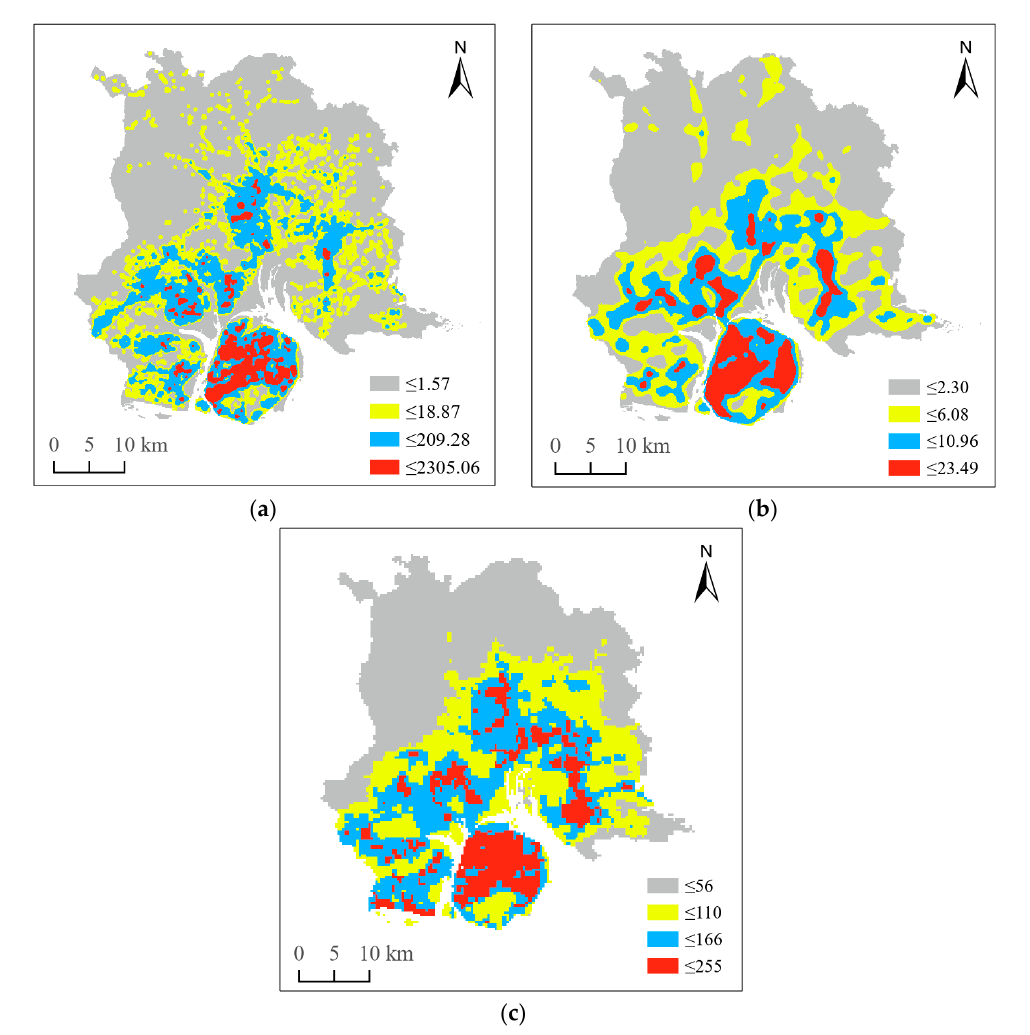
Figure 4. Intensity maps of ( a ) POI, ( b ) RN, and ( c ) NTL.